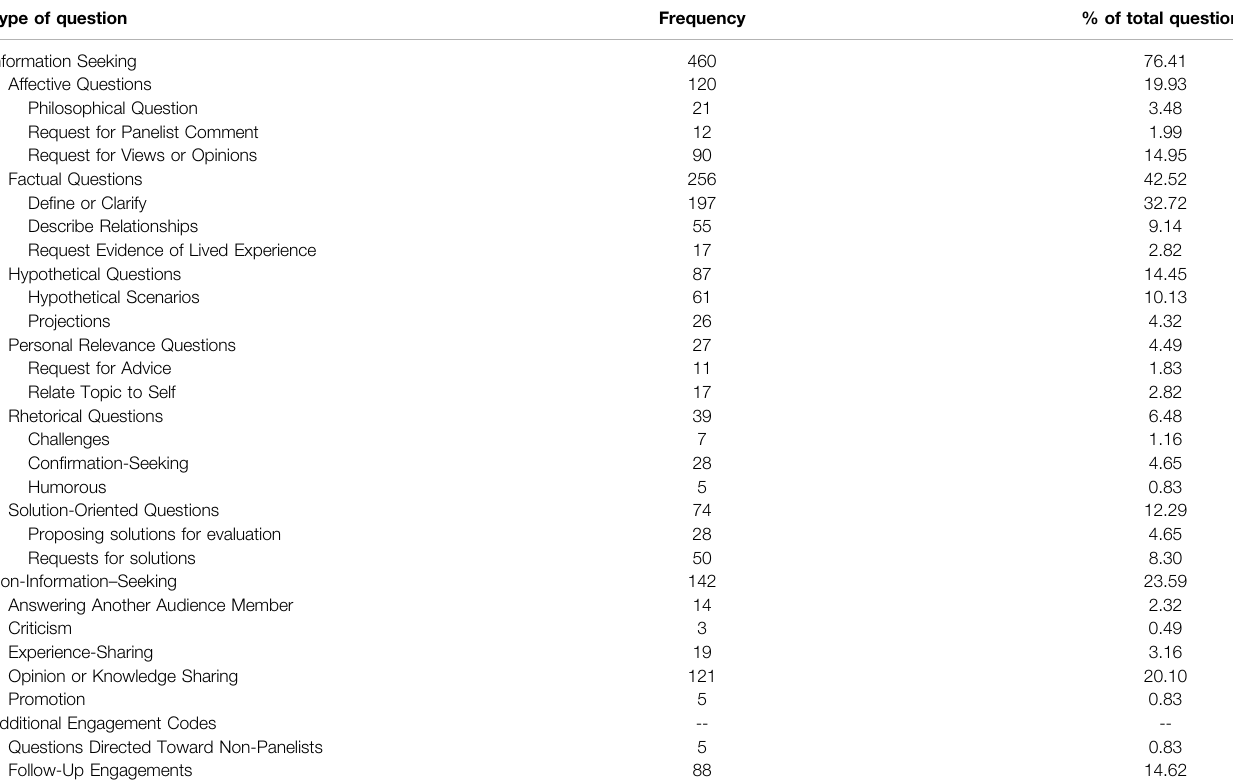
TABLE 5 | Frequencies of all types and subtypes of question-asking behaviors. Type of question Frequency Information